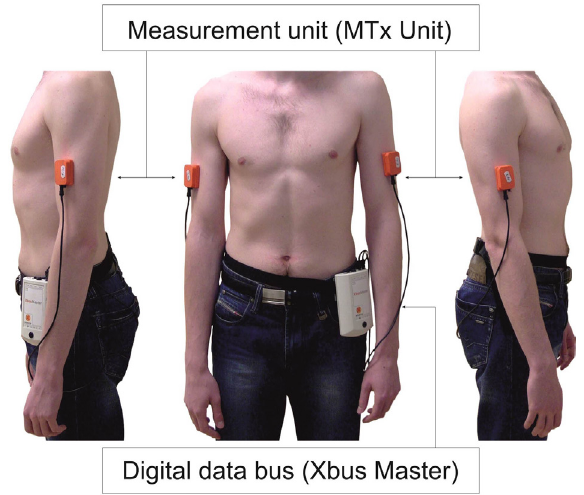
Arrangement of the Xsens system with two three-axis IMUs used to measure acceleration of upper